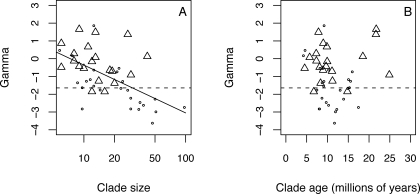
The Observed Relationship between γ and Clade Size and Age across Bird Phylogenies(A) Plot of the γ statistic versus clade size, where clade size is the total number of lineages estimated to be present 2 Mya for 45 bird clades (Table 1). All values below the dashed line are significant at p < 0.05. The least squares regression slope is b = −1.10 ± 0.24, p < 0.001.(B) Plot of the γ statistic versus clade age. Circles and triangles represent passerine and nonpasserine clades, respectively.